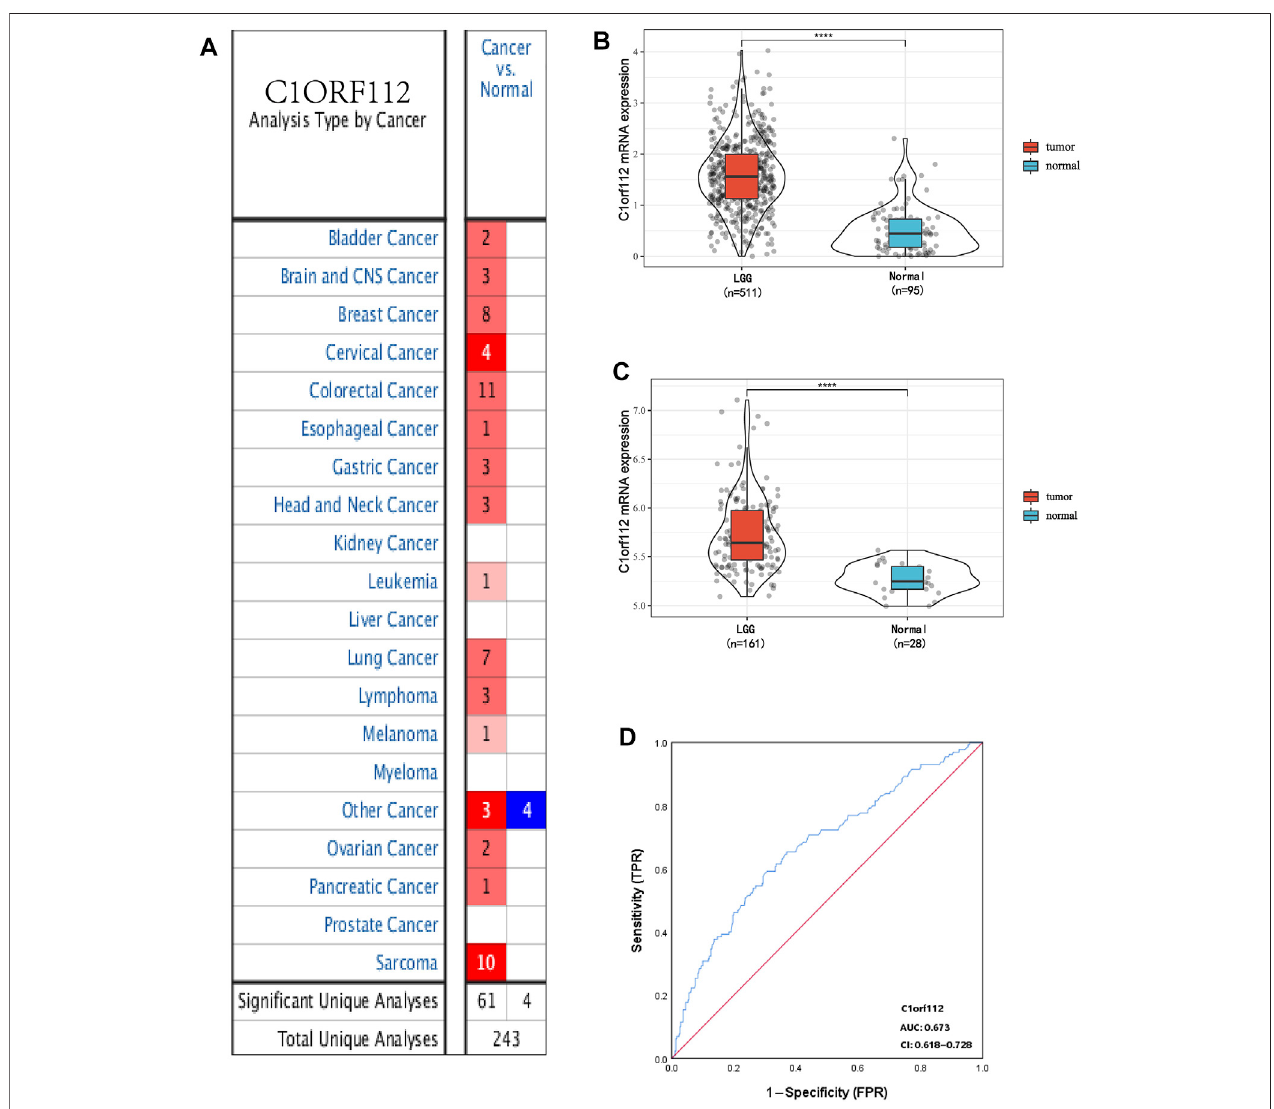
FIGURE 1 | C1ORF112 expression between cancer and normal tissues in LGG patients. (A) . Transcriptional expression of C1ORF112 in different types of cancer diseases. C1ORF112 mRNA is highly expressed in low-grade glioma tissues in TCGA dataset (B) and Rembrandt dataset (C) . (D) Receiver operating characteristic analysis (ROC) of C1ORF112 in LGG. **** p < 0 .0001.